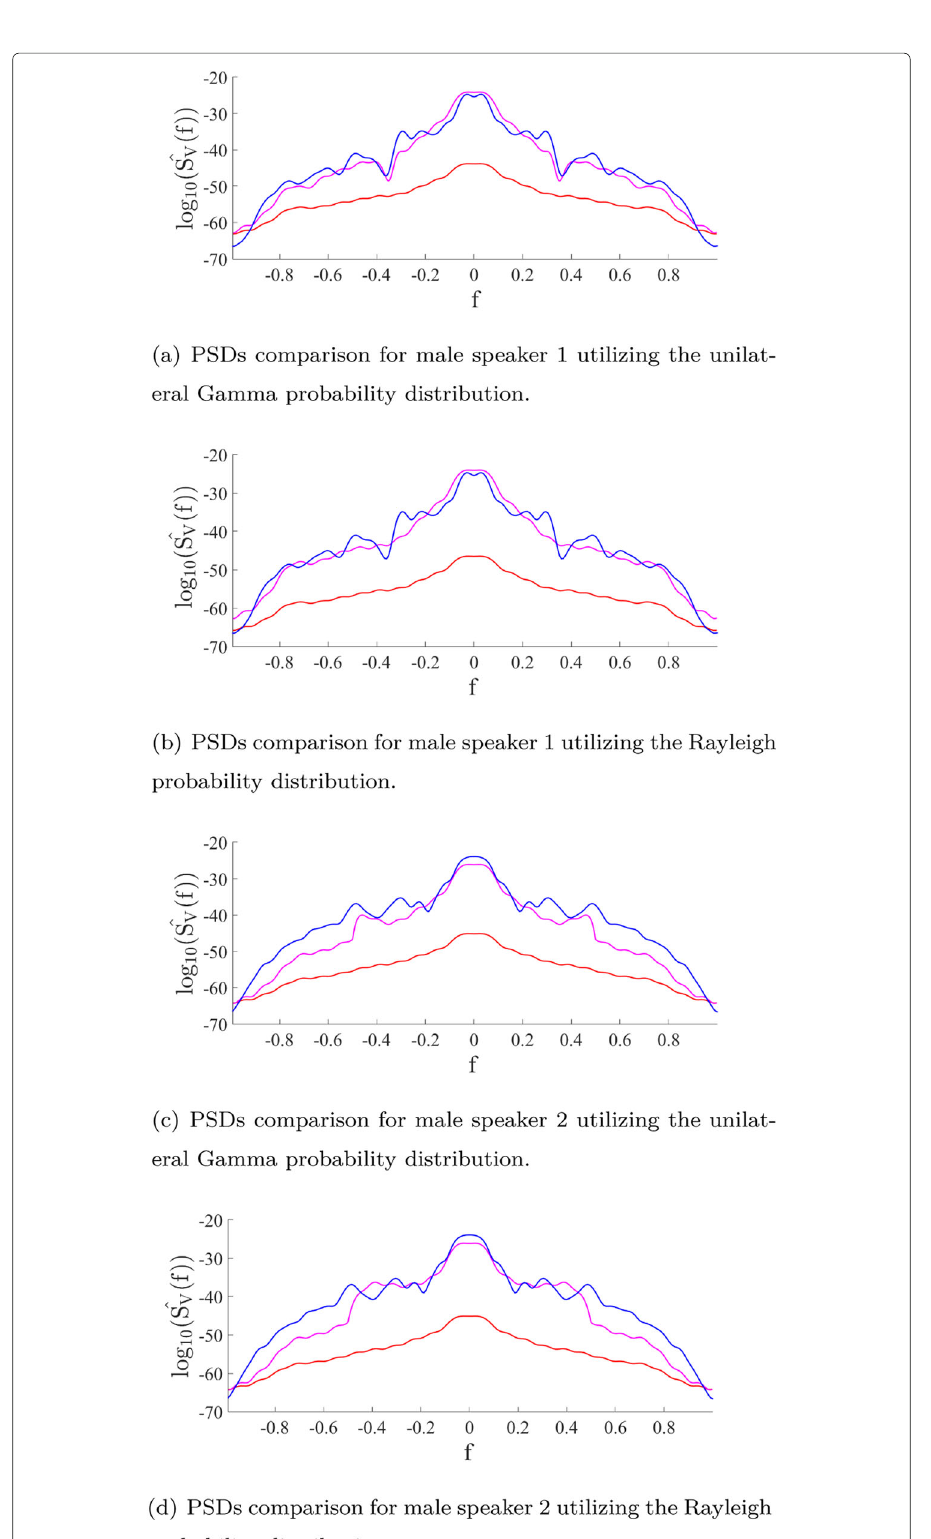
Fig. 13 Power spectral densities curves, as a function of the frequency f ( × π rad / s ) , for male speakers: new voice generation model (lilac), classic source-filter (red) and estimated by voice locution